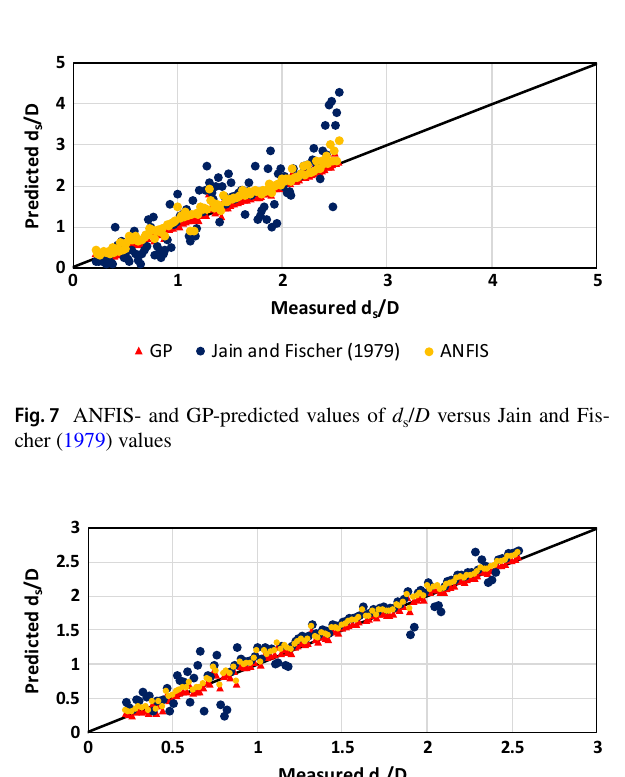
Fig. 9 ANFIS- and GP-predicted values of d Froelich (1999) values